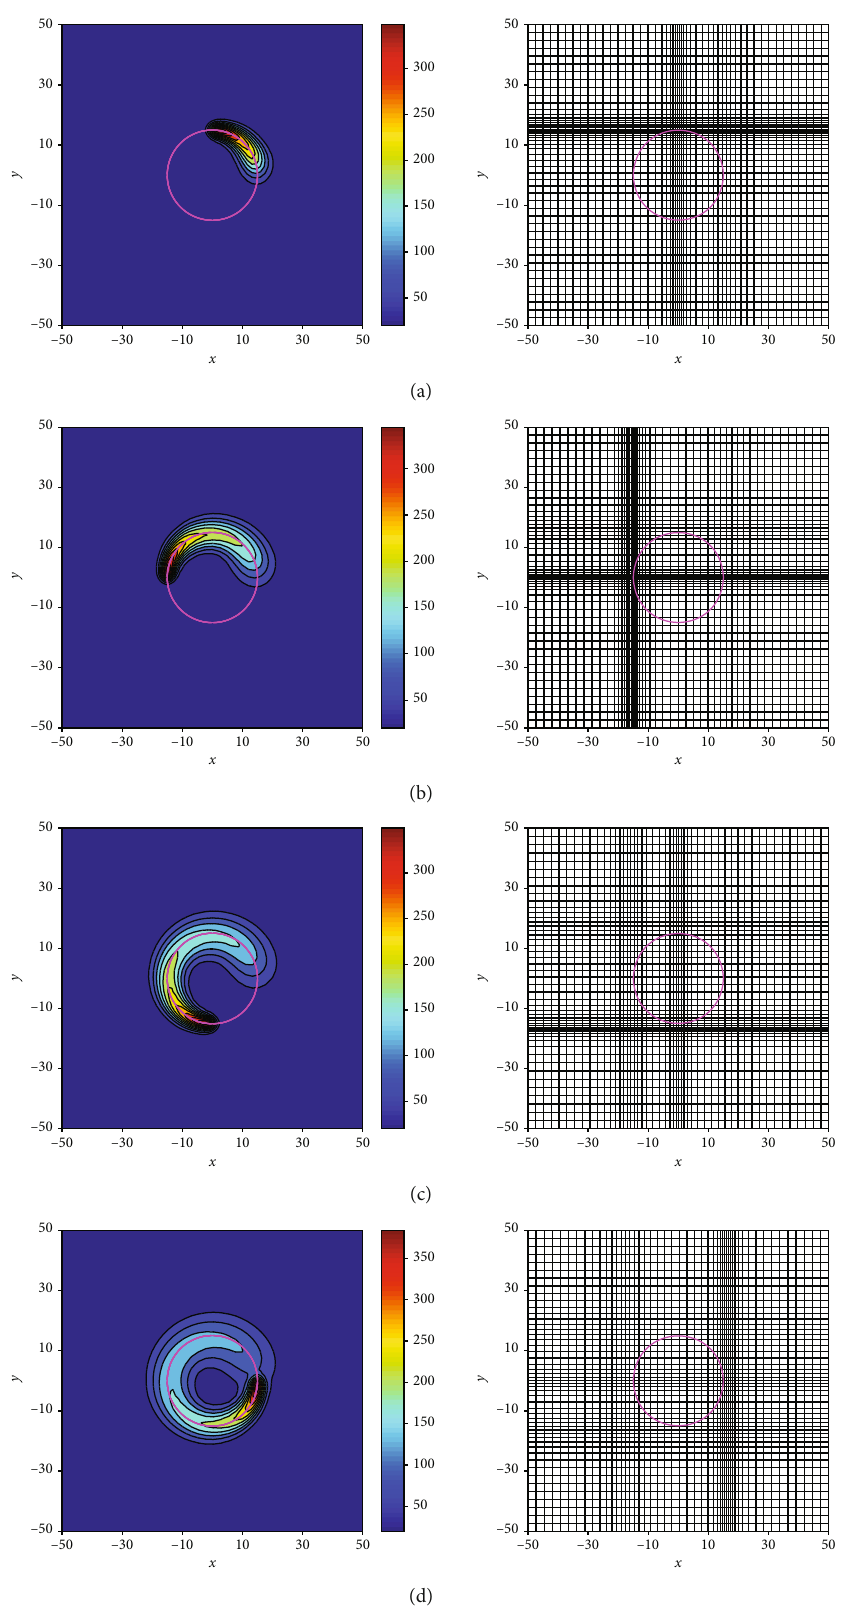
Figure 4: The transient temperature fi eld and the corresponding moving mesh at t = 1 (a), 2 , 3 , and 4 (d), respectively, for a single heat source moving along a circle in a counterclockwise